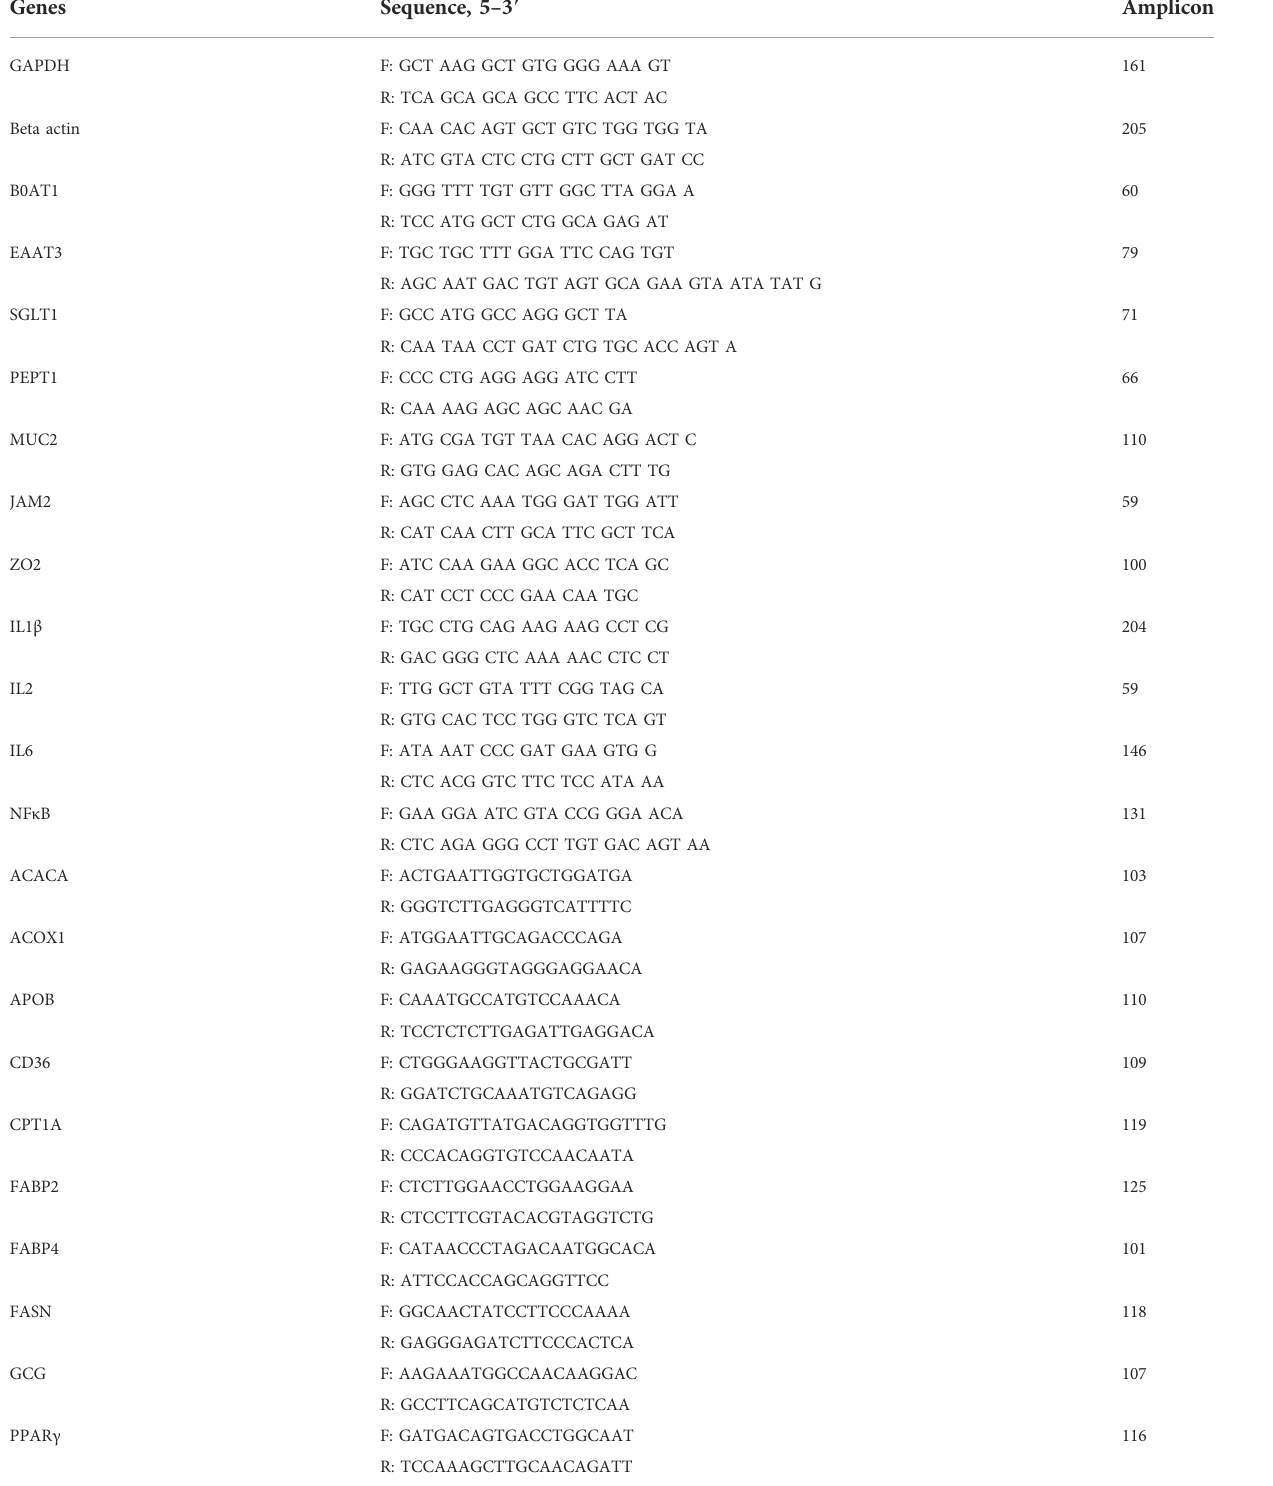
TABLE 2 Primers used in the study. 1